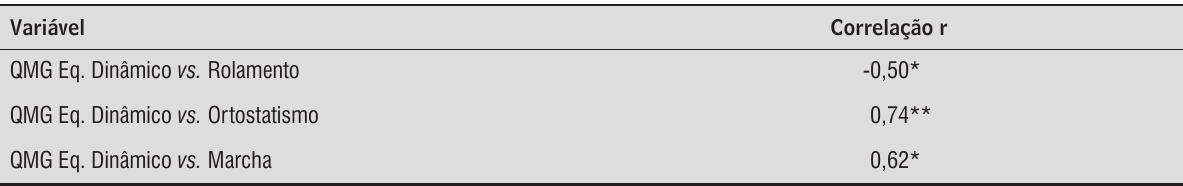
QMG Eq. Dinâmico vs.